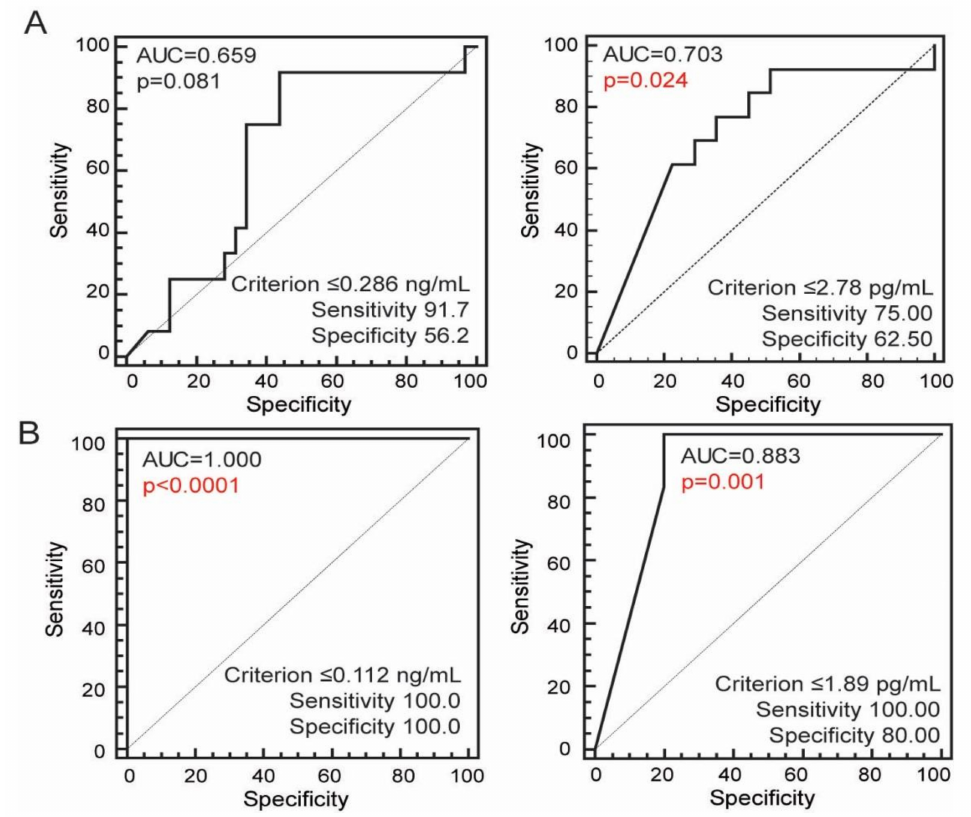
Figure 4. Ability of sFas and sFasL concentrations in sera of all patients with RRMS ( A , N = 44), and patients with disease duration ≥ 10 years ( B , N = 11) to discriminate between RRMS patients with mildorabsentdisability(EDSSscore ≤ 3.0)andpatientswithmoderatetoseveredisability(EDSS > 3)[36]. The sensitivity, specificity, and a “cut o ff ” point (criterion) of sFas and sFas concentrations were assessed by ROC curve analysis. AUC, area under curve; ROC, receiver operating characteristics.